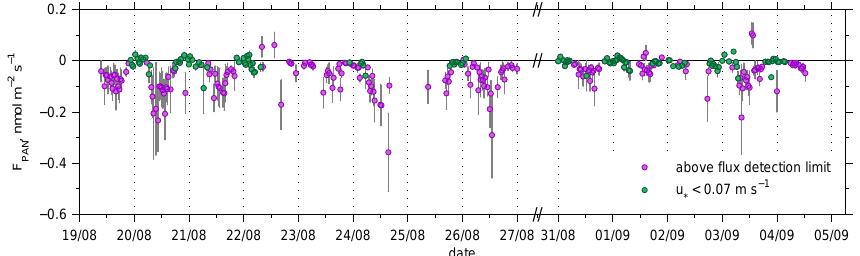
Figure 3. Overview of PAN flux measurements using the MBR method from 19 August to 4 September 2011 at the Mainz Finthen grassland site after applying quality criteria as described in Moravek et al. (2014). Error bars represent the random flux error and green values indicate periods with weak turbulent exchange ( u ∗ <0.07ms − 1 ) .